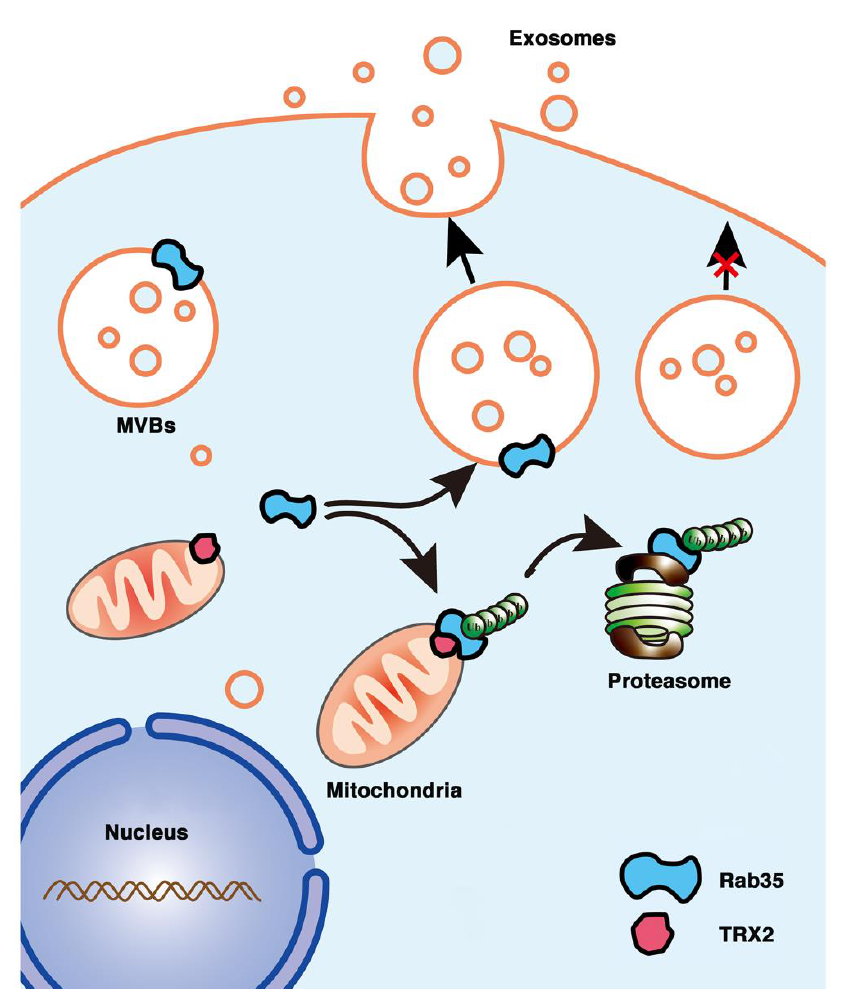
Figure 8. Schematic representation of the role of the TRX2/Rab35 interaction in the regulation of exosome secretion. Rab35 (at the cytosolic face of endosome-MVBs) mediates MVB docking to the cell membrane to promote exosome secretion. Mitochondrial TRX2 (on the mitochondrial membrane) interacts with Rab35 and induces Rab35 ubiquitination and degradation, resulting in impaired exosome secretion.